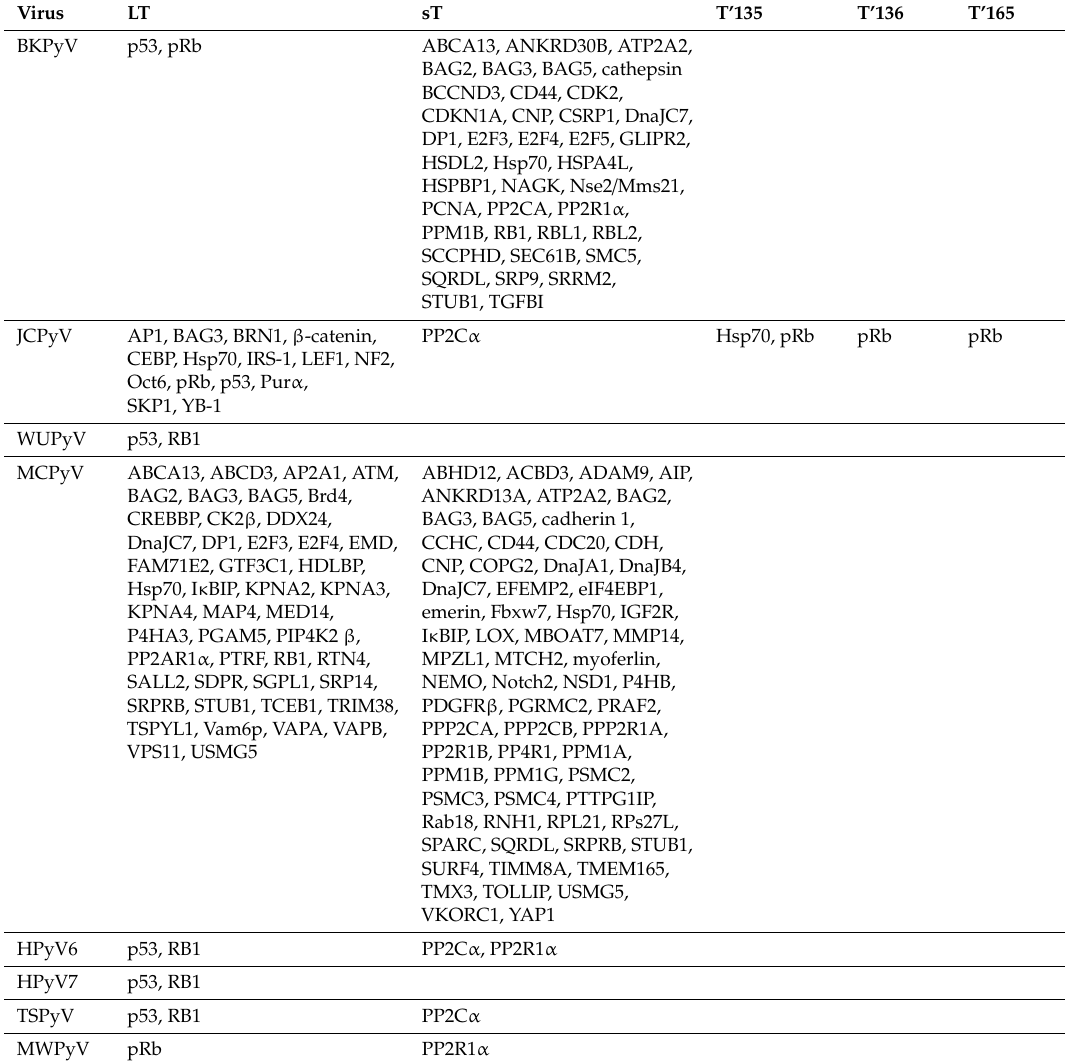
Table 1. Cellular proteins identified to interact with the early proteins of HPyV